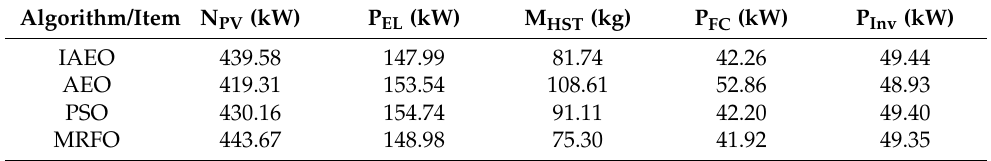
Table 5. Results related to scaling the HPV/FC energy system considering ENSP max = 5%. Table 6. Statistical analysis for different algorithms in the sizing of the HPV/FC energy system considering ENSP max = 5%.